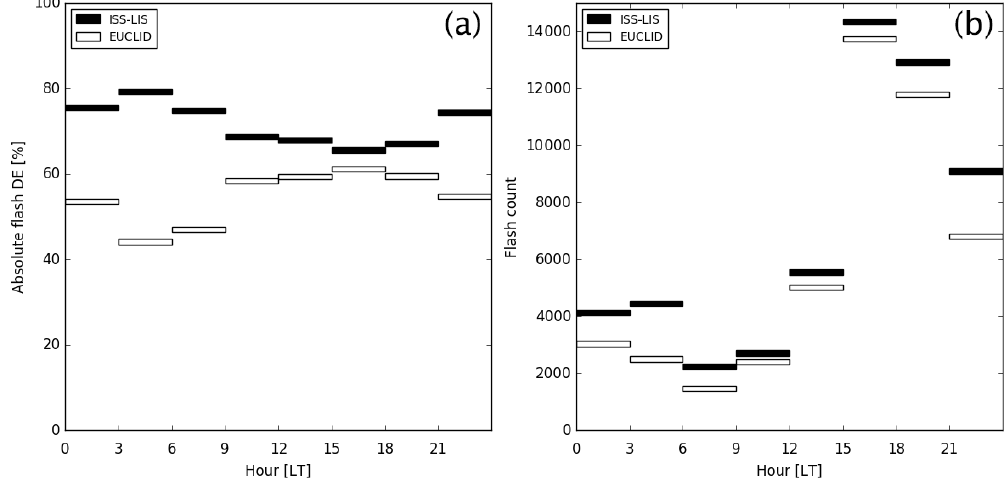
Figure 10. Diurnal distribution of the ISS-LIS and EUCLID (a) absolute flash detection efficiencies and (b) flash counts.